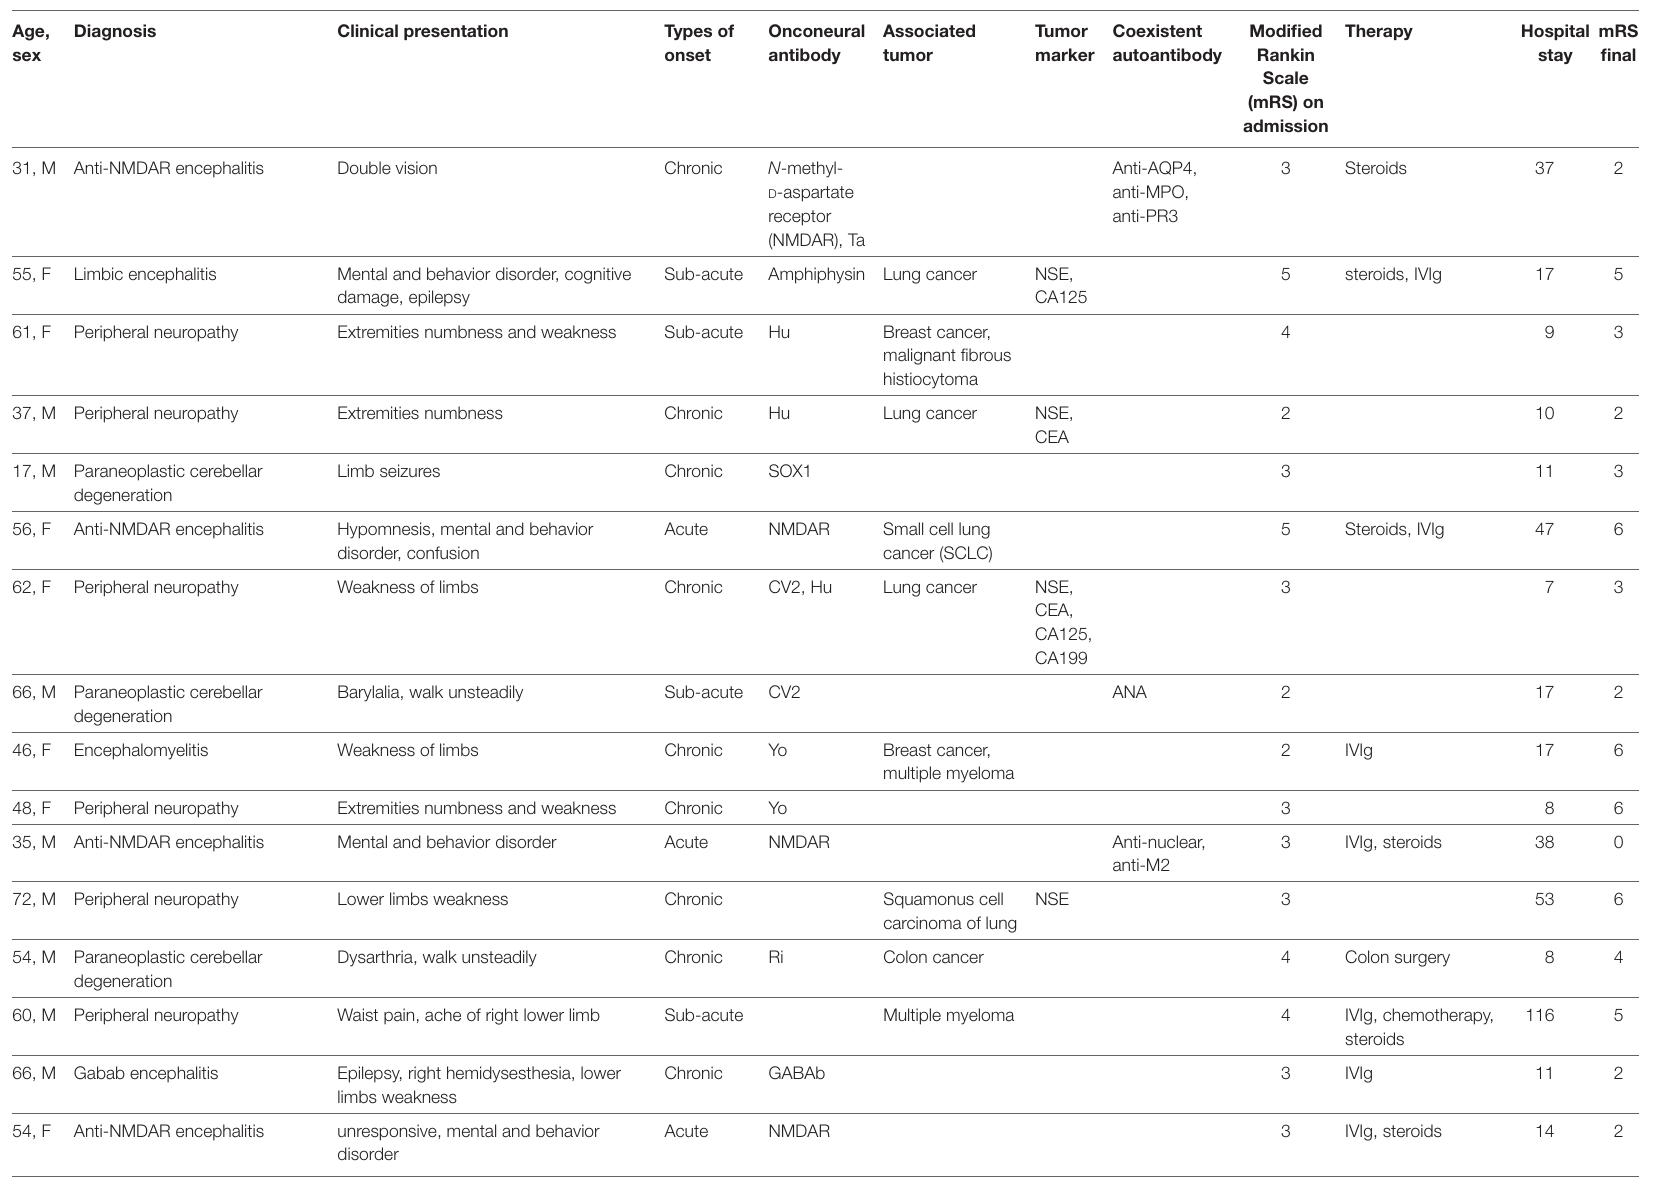
Table 1 | Demographics, clinical presentation, management, and